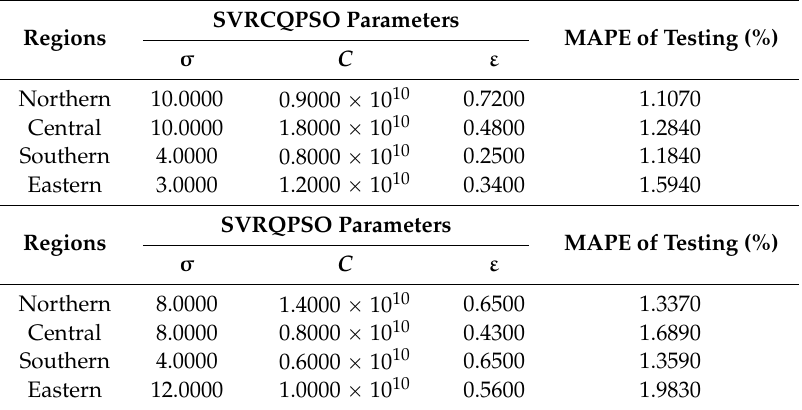
Table 1. Parameters determination of SVRCQPSO and SVRQPSO models (example